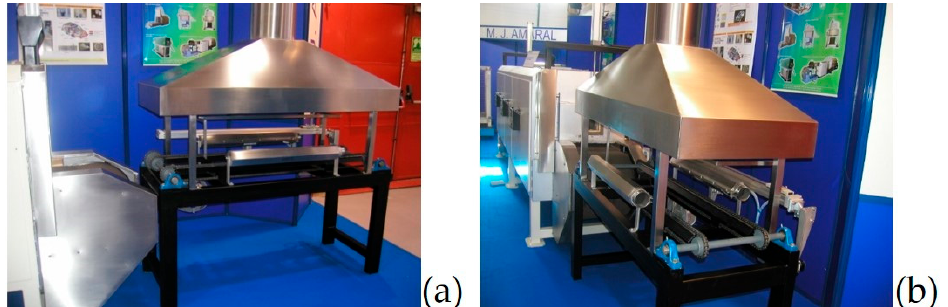
Figure 6. Cooling sector ( a ) and the automated continuous production line developed ( b ) for fabricating parts made of metallic foams.